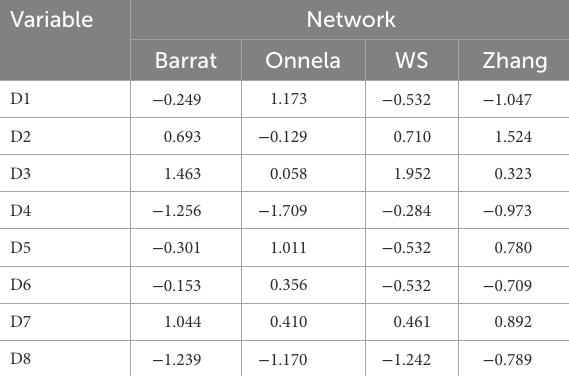
TABLE 5 Clustering measures per variable.